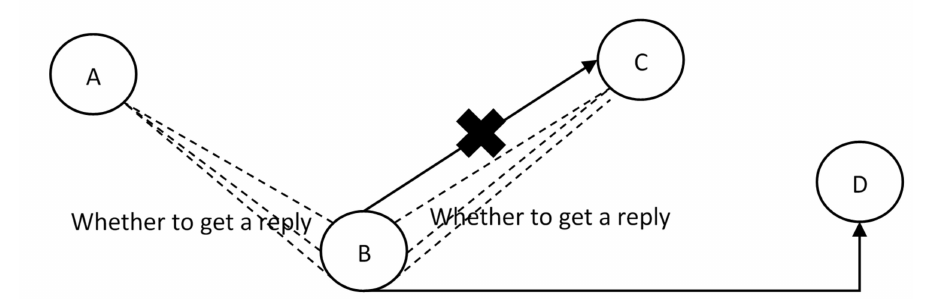
Figure 12. Schematic diagram of nodes.